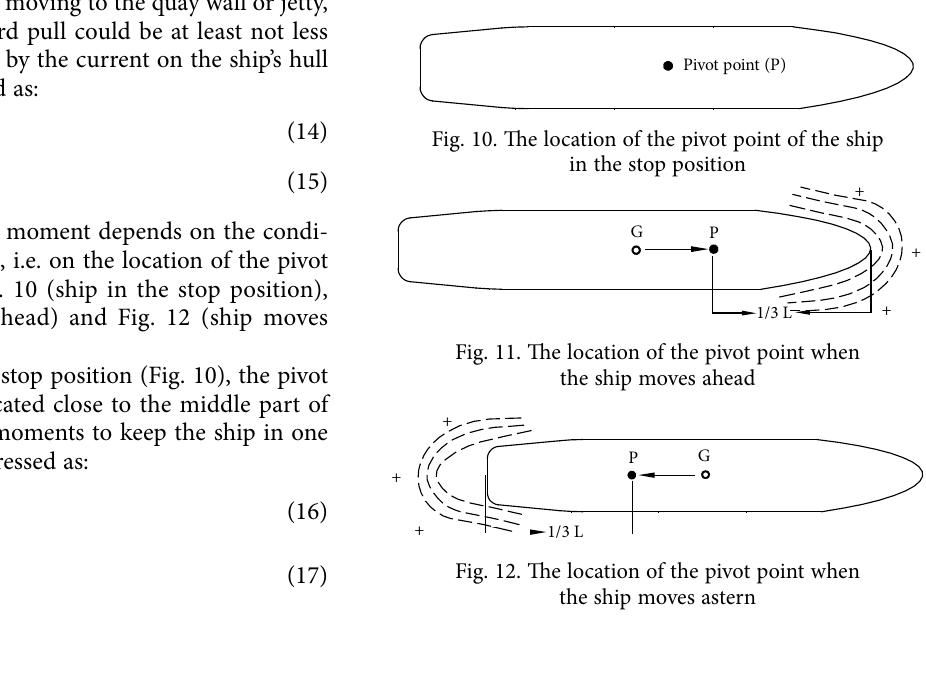
Fig. 9. The current acting on different parts of the ship